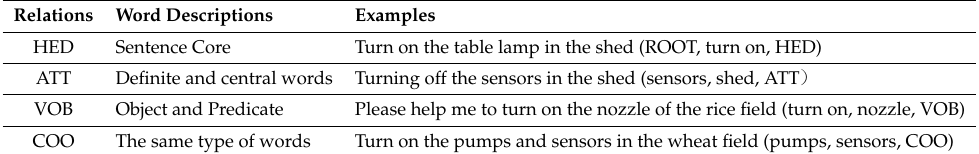
Table 1. Common dependency.